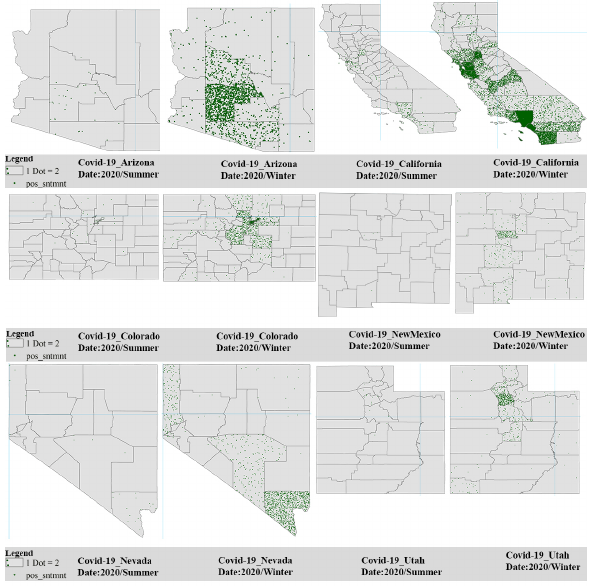
Figure 7. GIS Analysis for Covid-19 Infected